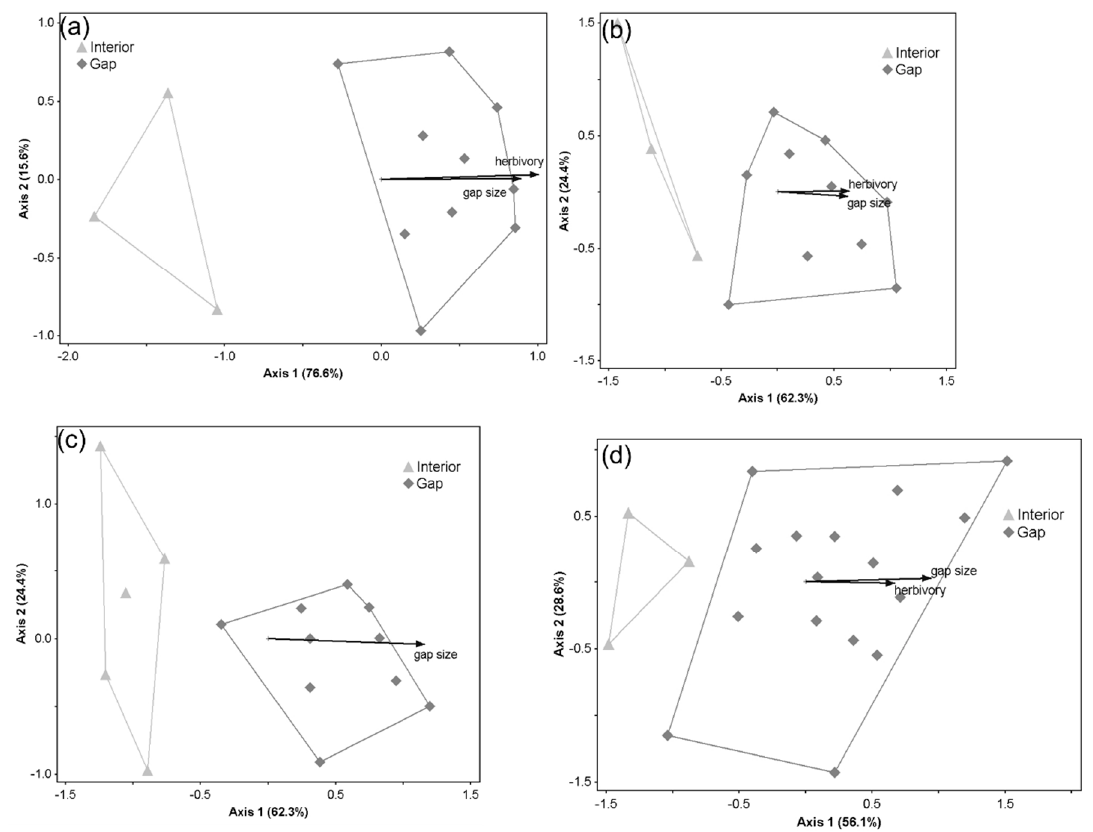
Figure 3. Nonmetric multidimensional scaling (NMS) ordinations of understory plant communities in gap and interior forest locations for the ( a ) Birch Cut, ( b ) Big Pine, ( c ) Power Line, and ( d ) Schoolhouse study areas. Vector length represents explanatory power of environmental variables (only variables with r 2 > 0.2 are depicted). Ordination diagrams were rigidly rotated to place the variable “gap size” parallel with the NMS axis 1. See Table 1 for study site information.